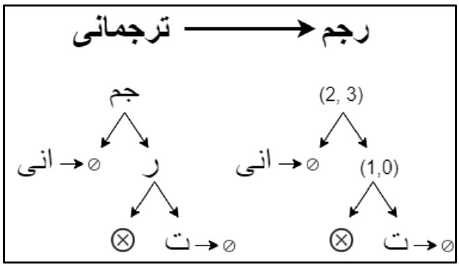
(cid:81)(cid:16) (cid:75) (cid:46) ” -/tarjamani/